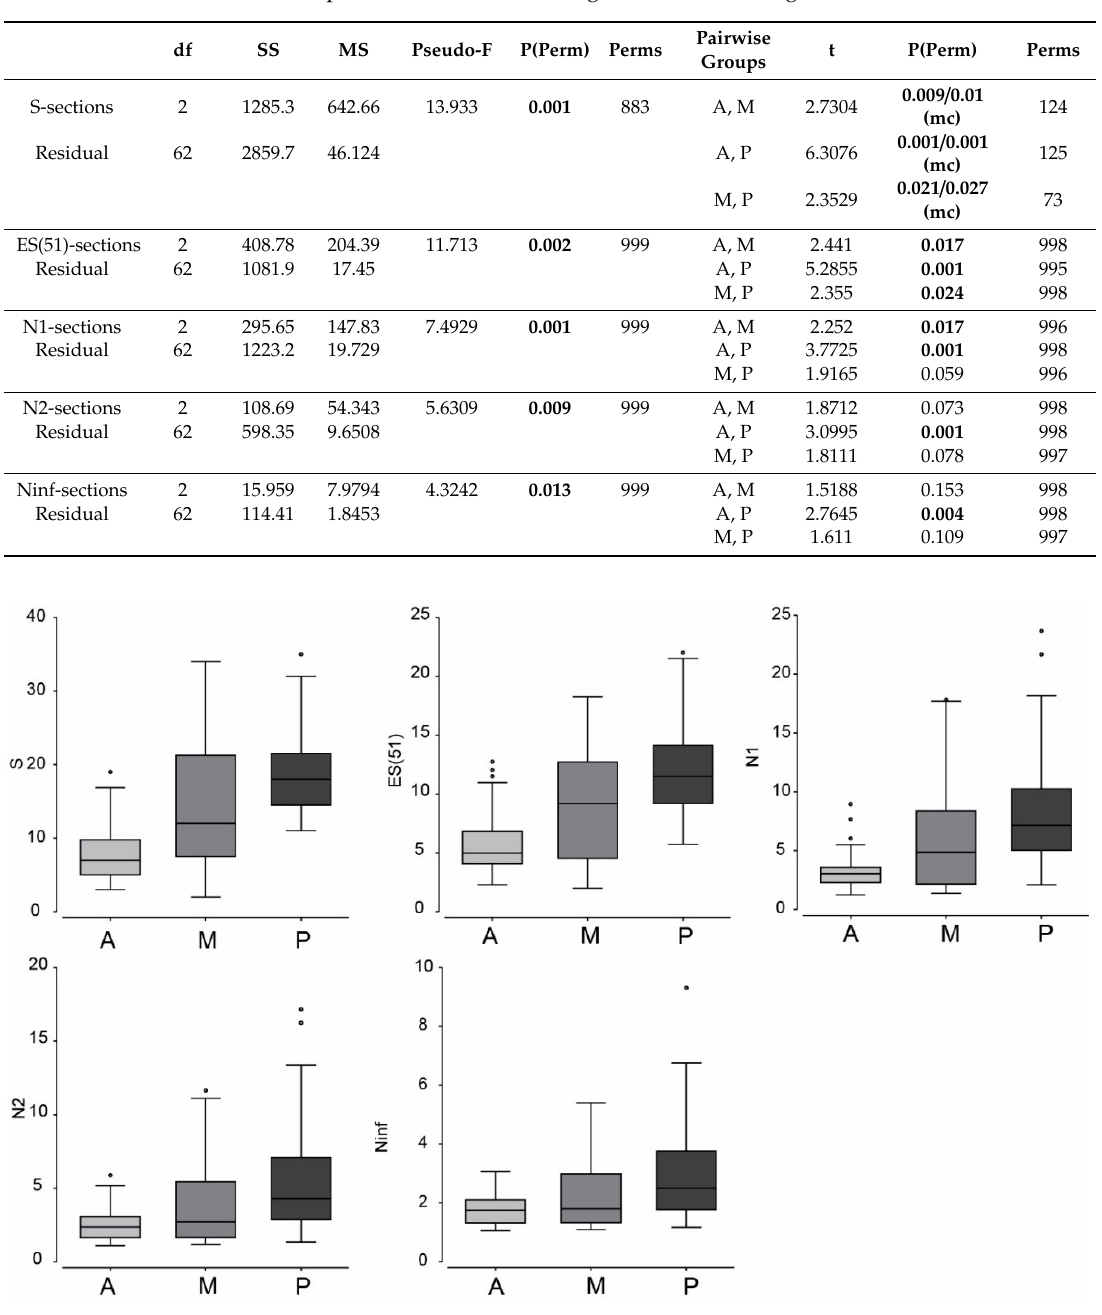
Table 2. Main and pairwise PERMANOVA test results for nematode genera diversity indices. Comparison between carapace sections, cf. Figure 8. Df: degrees of freedom; SS: sums of squares, MS: means of squares, perm(s): permutation(s), A: anterior, M: middle, P: posterior, mc: Monte Carlo values when the number of permutations were low. Significant values are given in bold.